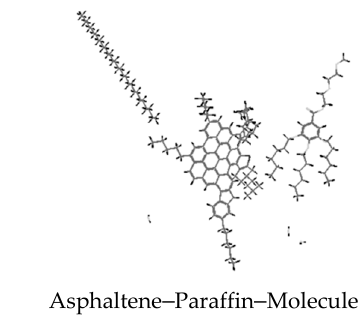
Figure 2. Free-water conglomerate interactions.